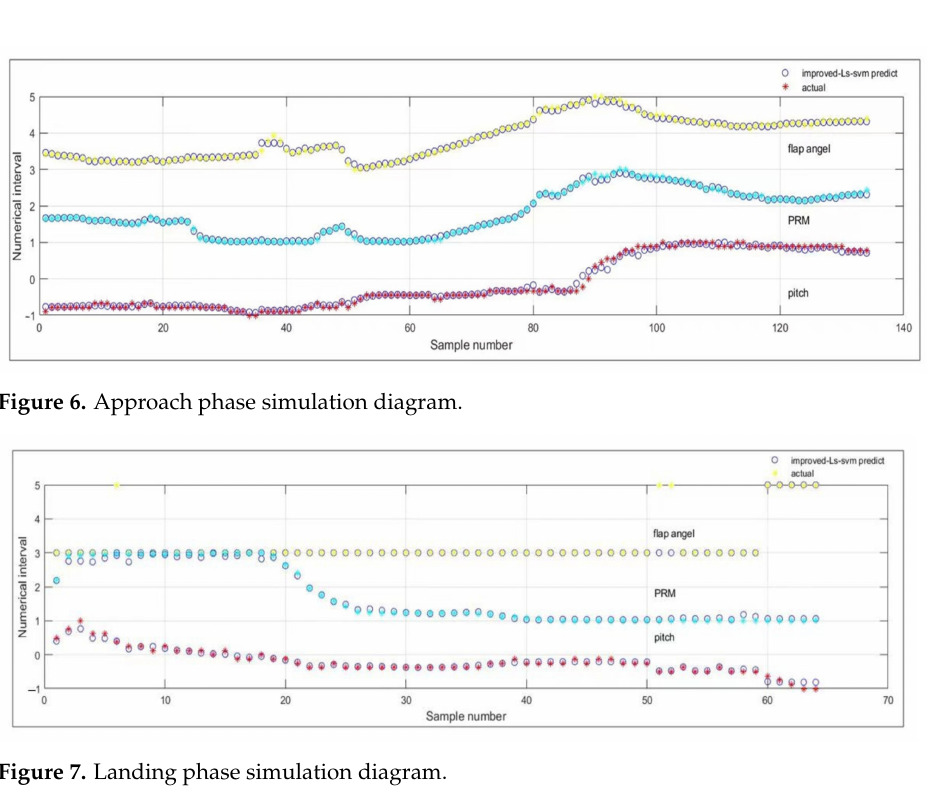
Figure 7. Landing phase simulation diagram.